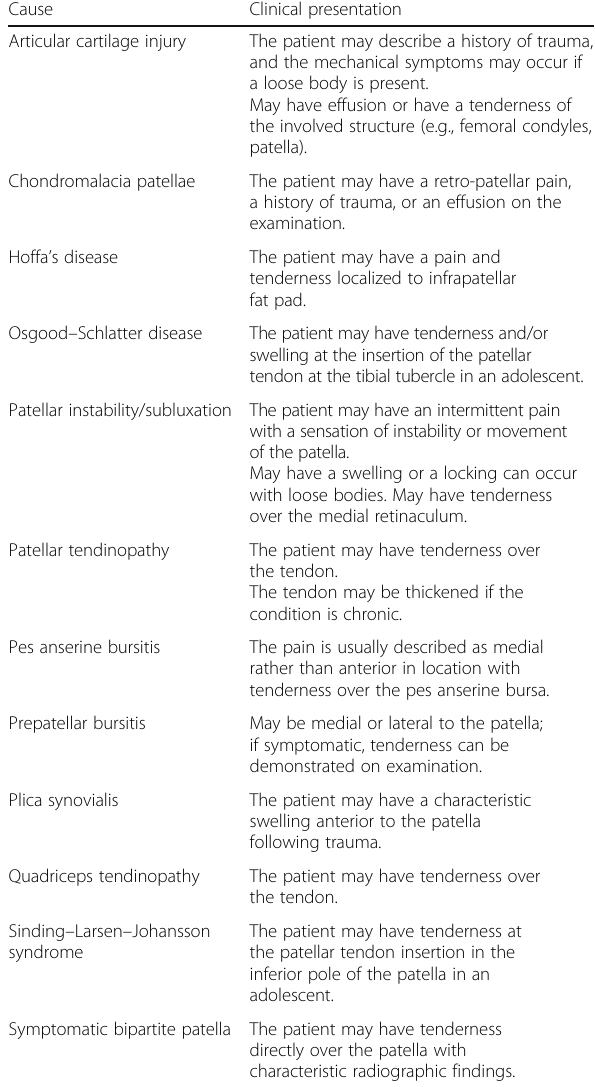
Table 1 Summarizing the differential diagnosis for the common causes of the AKP and their clinical presentations